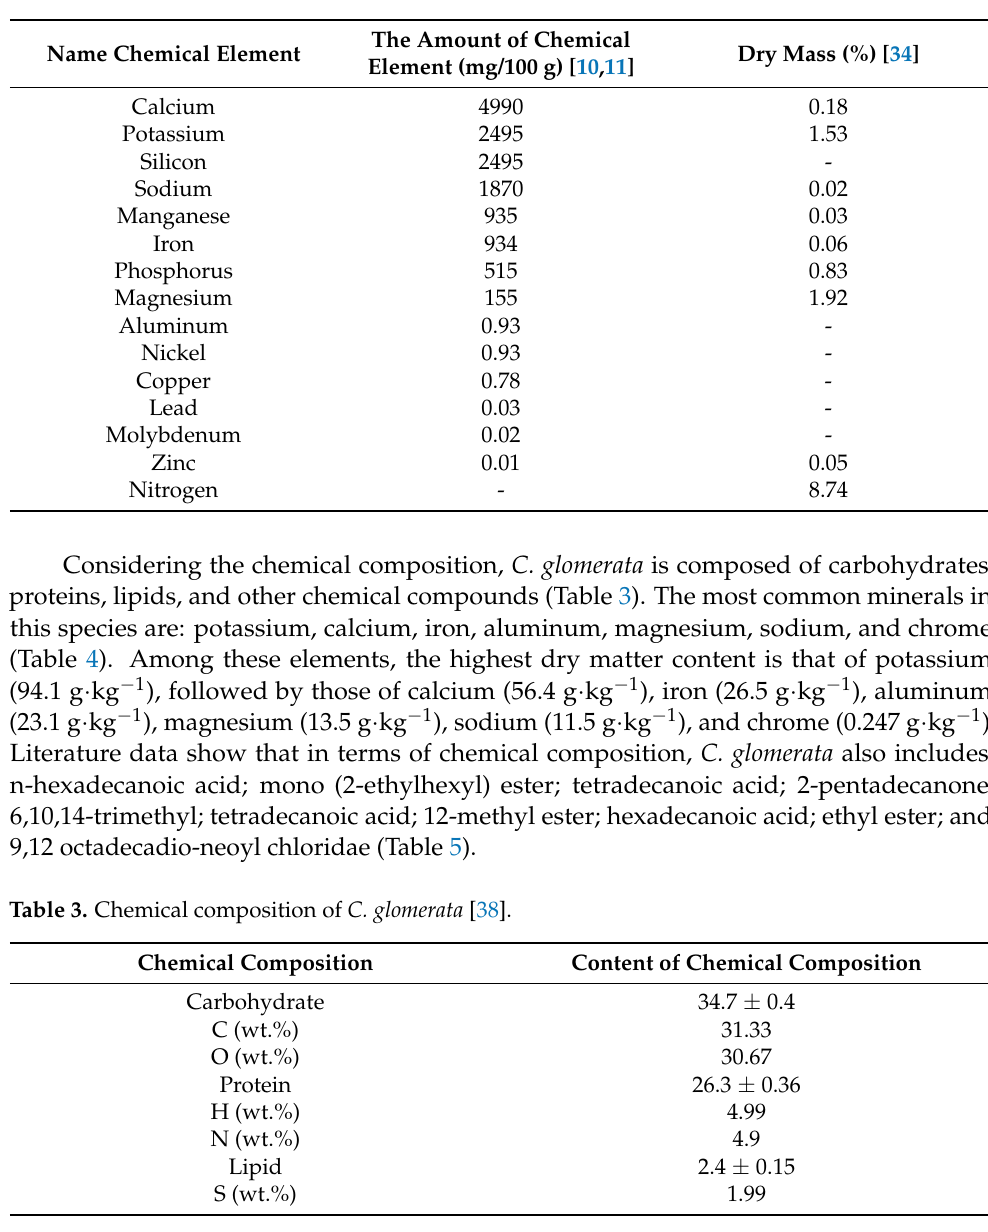
Table 2. The content of chemical elements in L. minor .